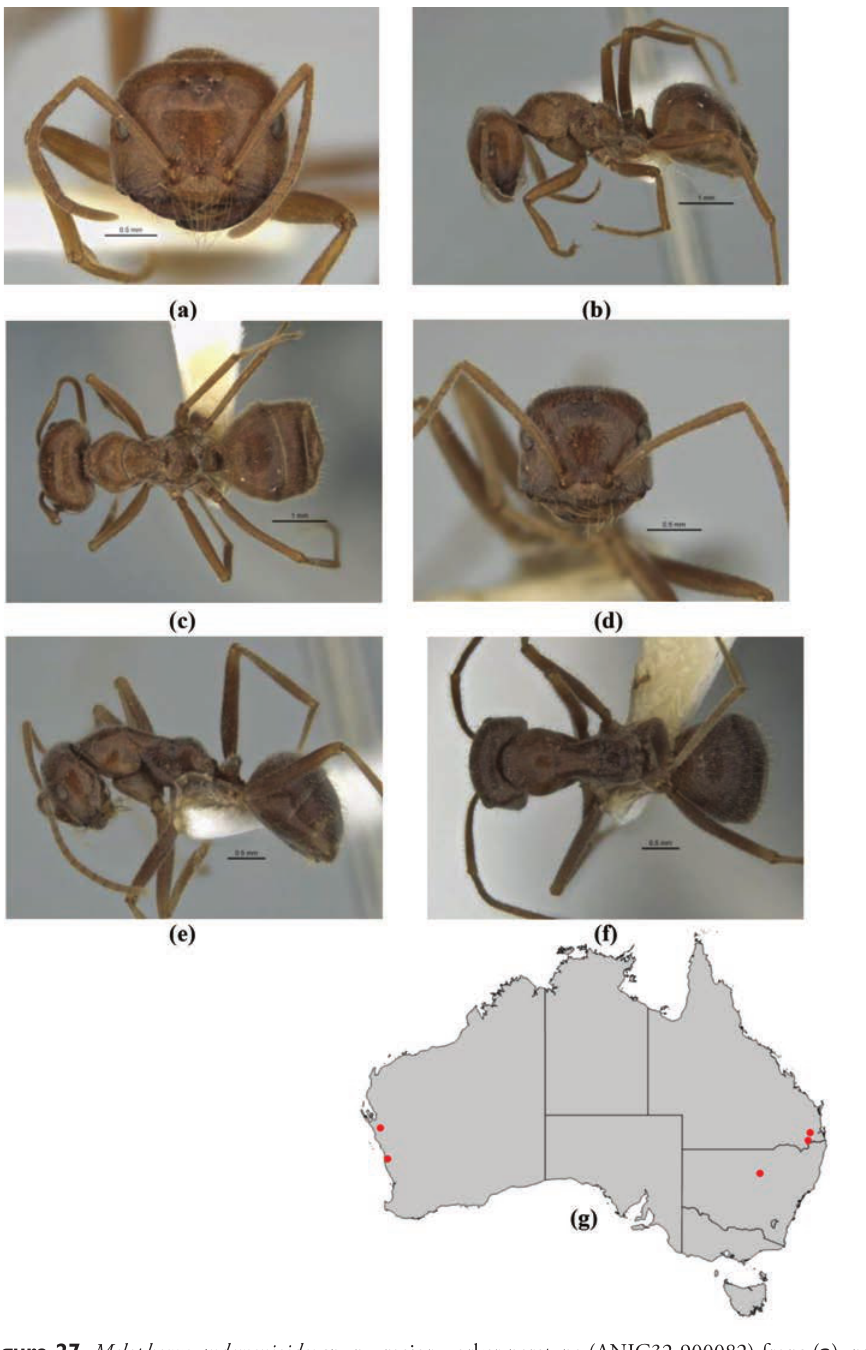
Figure 27. Melophorus andersenioides sp. n.: major worker paratype (ANIC32-900082) frons ( a ), pro- file ( b ) and dorsum ( c ); minor worker holotype (ANIC32-900082–bottom ant) frons ( d ), profile ( e ) and dorsum ( f ); distribution map for the species ( g ). Low resolution scale bars: 1 mm ( b, c ); 0.5 mm ( a, d–f